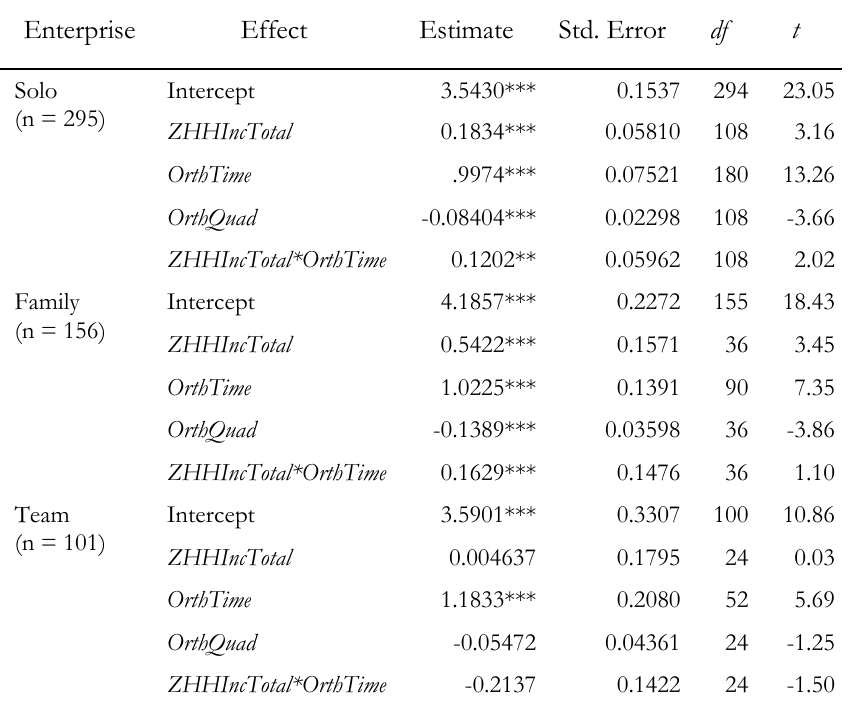
Table 2. Estimates of Fixed Enterprise